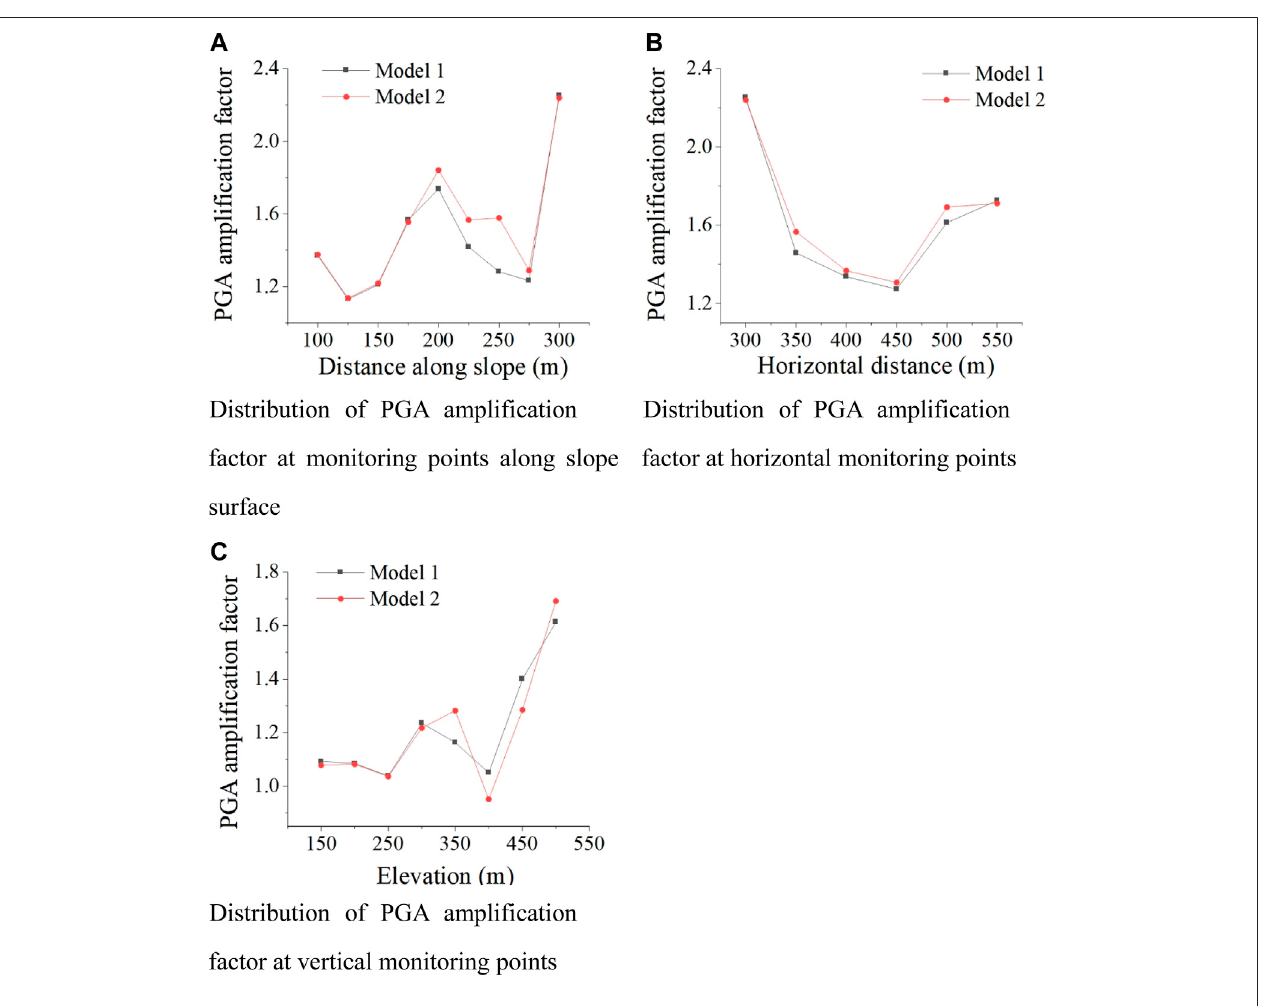
FIGURE 5 | PGA ampli fi cation factor of the monitoring points of slope. (A) Distribution of the PGA ampli fi cation factor at monitoring points along the slope surface. (B) Distribution of the PGA ampli fi cation factor at horizontal monitoring points. (C) Distribution of PGA ampli fi cation factor at vertical monitoring points.